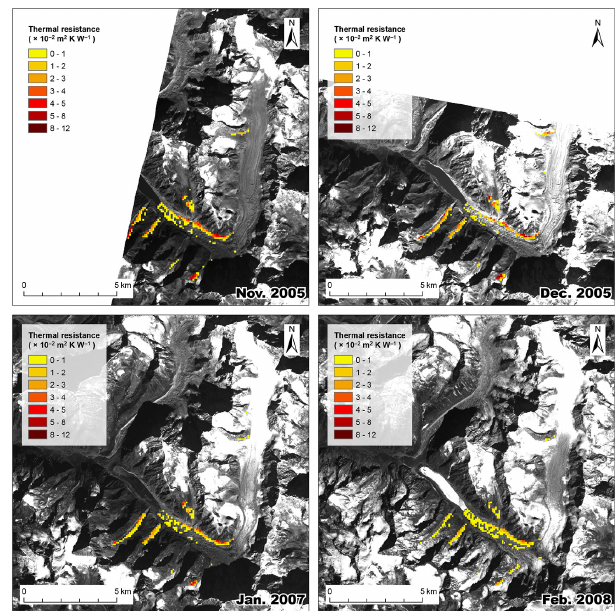
Figure 5. Distributions of thermal resistance in individual ASTER scenes on the Trambau Glacier, which were not used in the runoff